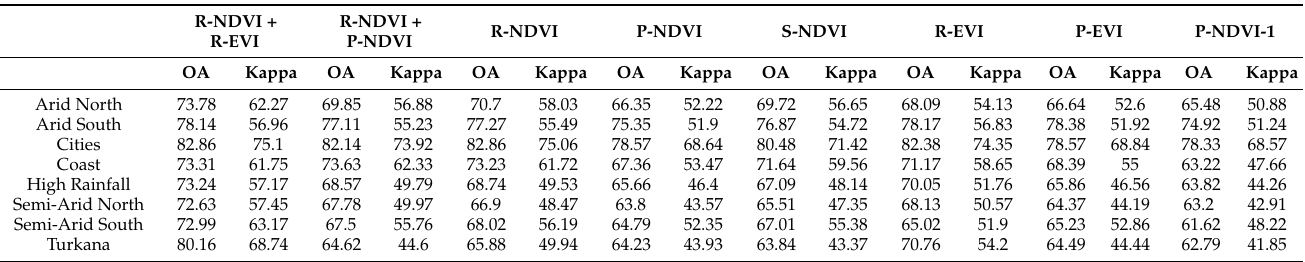
Table 2. Accuracies (Overall Accuracy and Kappa Accuracy) were achieved for RF in different AEZs and different datasets.